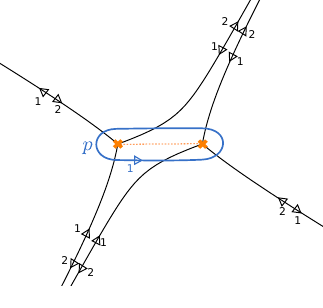
Figure 34 . A cycle p on e C , with [ p ] = X (cid:13) in Sk( f M; gl